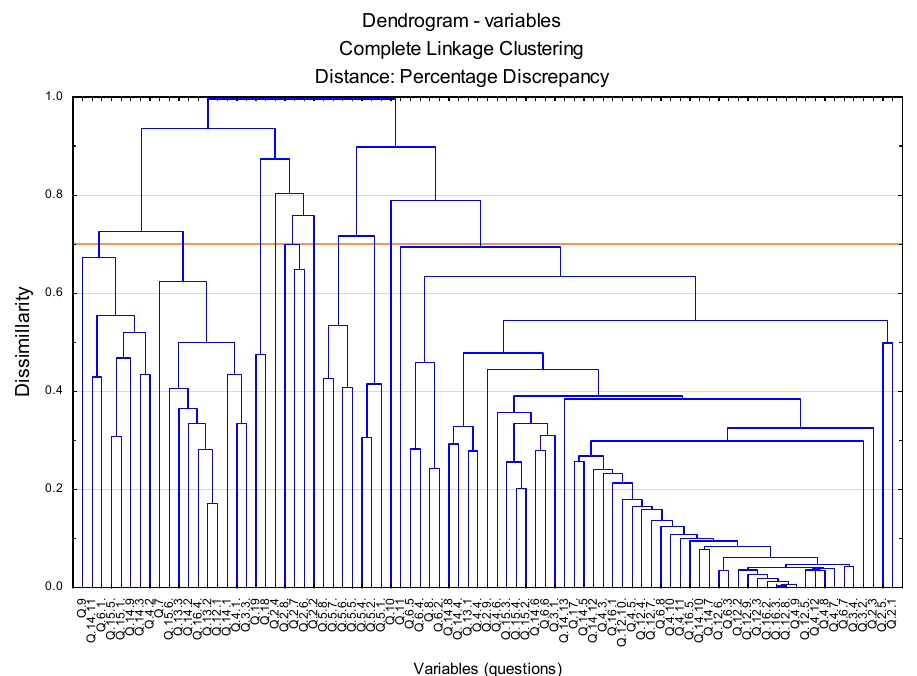
Figure 1. Dendrogram of variables agglomeration. Agglomeration of variables using the k -means method resulted in 10 clusters of var- iables with similar values in the sample. For each cluster, arithmetic averages of the values for each observation were calculated. This resulted in 10 new synthetic variables (Cl01- Cl10). These variables are artificial creations and have no natural interpretation. However,